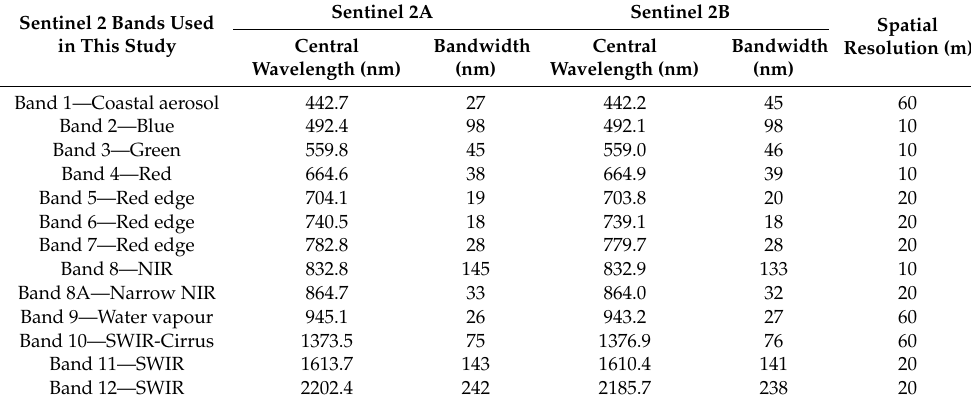
Table A1. Spectral bands for the Sentinel 2 sensors.